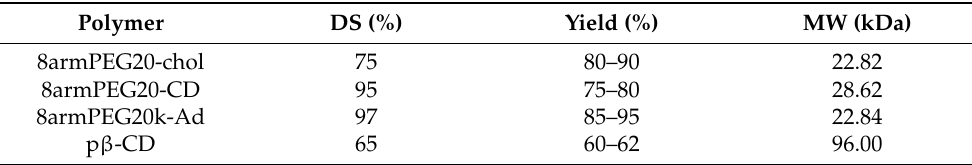
Table 1. The degree of substitution (DS), yield, and molecular weights (MWs) of the synthesized polymers utilized for the construction of hydrogel systems.